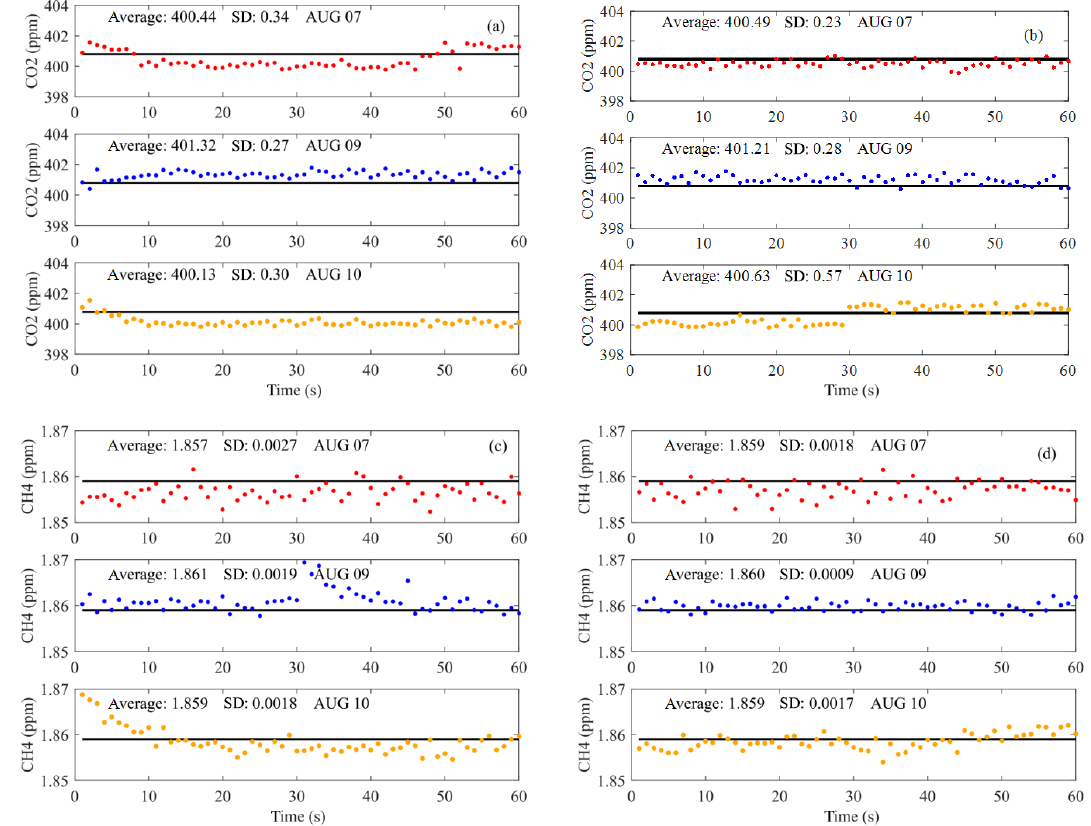
Figure 2. The concentrations of CO 2 (a) and CH 4 (b) before the flight and the concentrations of CO 2 (a) and CH 4 (b) after the flight obtained during the calibration, with the values of standard deviation and average of each